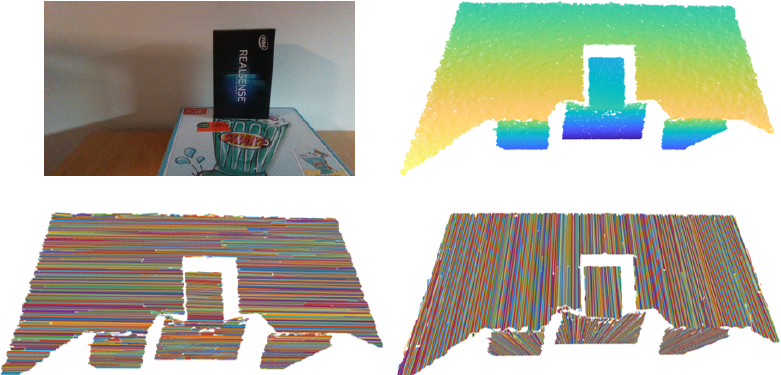
Figure 14. RGB scene and point cloud ( upper pictures). An example of line clustering within columns of the depth image, i.e., vertical clustering ( bottom right picture). The same applies for rows, since by transposing the depth image we achieve horizontal clustering ( bottom left